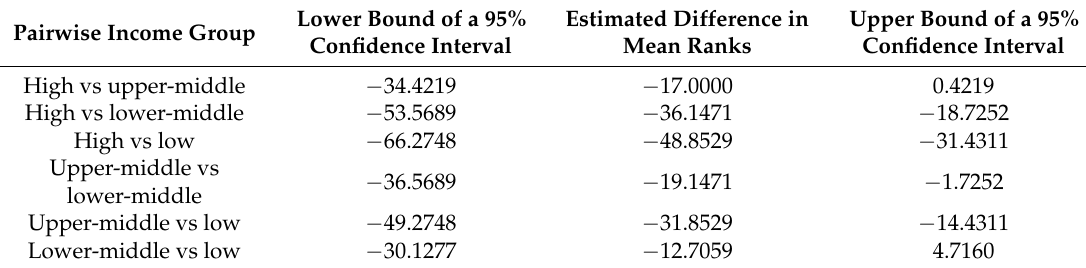
Table 4. Results of multiple comparison